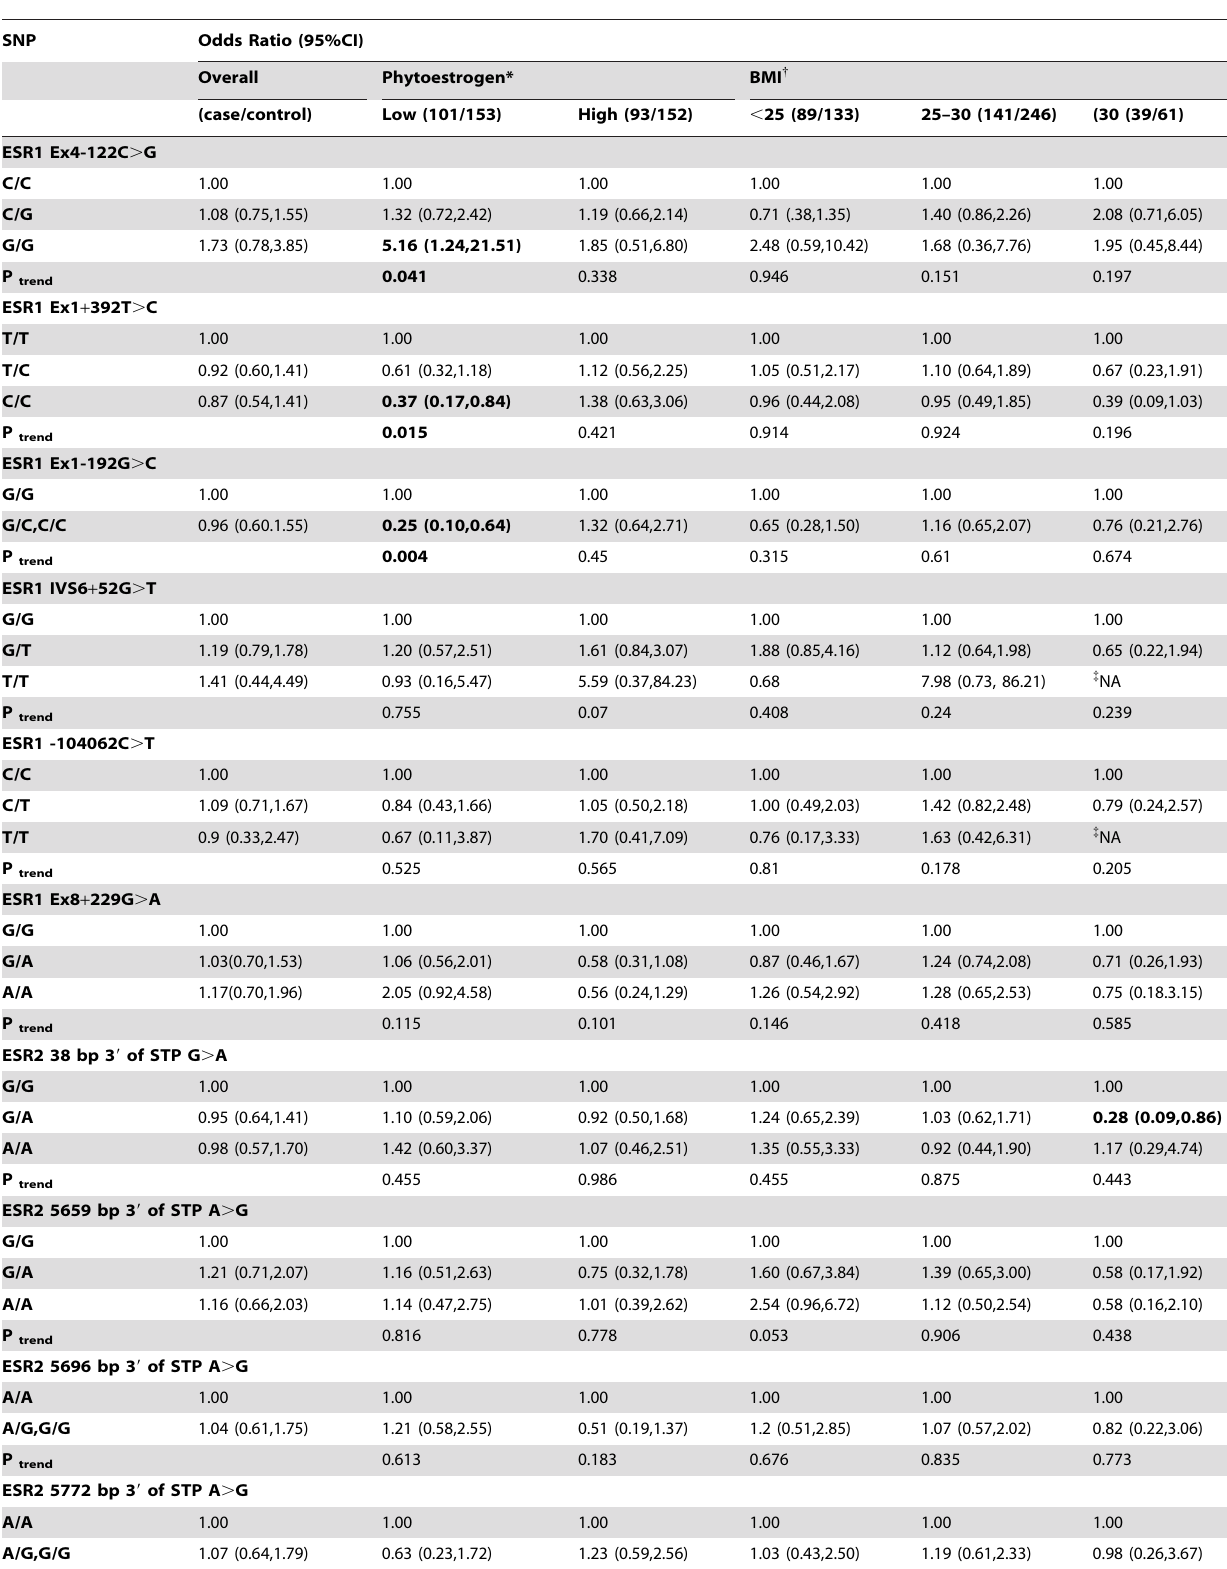
Table 3. Estrogen receptor gene polymorphisms and prostate cancer risk according to BMI and habitual dietary intake of